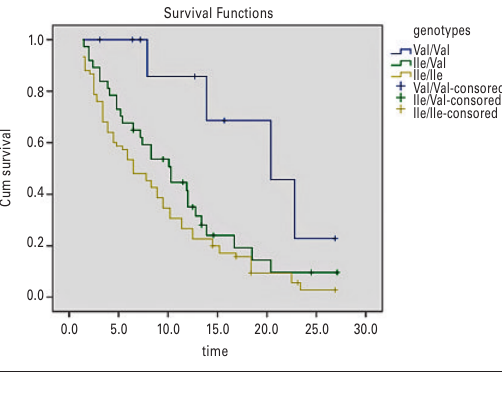
Response to chemotherapy according to GSTP1 genetic poly- morphisms.